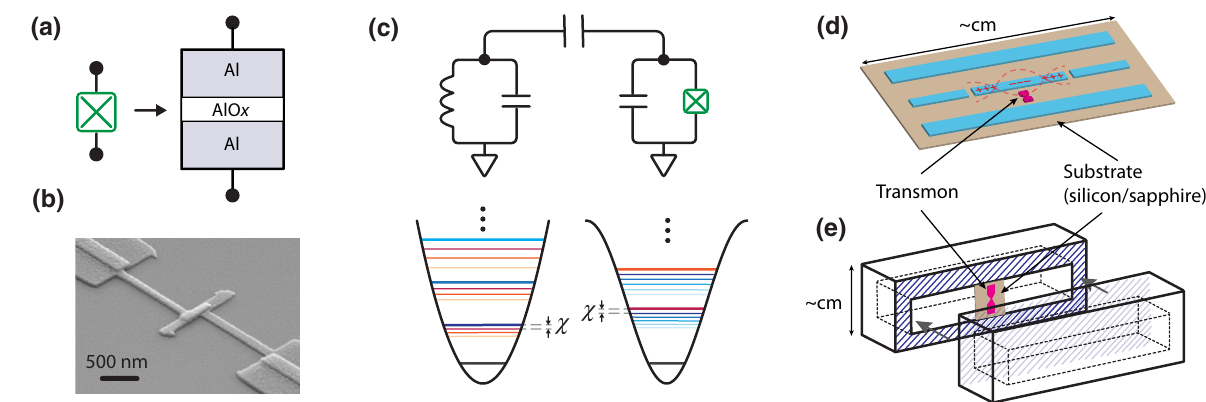
FIG. 3. Dispersive coupling between a transmon and a superconducting resonator. (a) Lumped-element representation of a Josephson junction and a sketch of its structure, which consists of two layers of aluminium (gray) that are separated by an aluminium oxide tunnel barrier (white). (b) A SEM image of a bridge-free junction. Image credit: Kyle Serniak (Yale University). (c) Lumped- element representation of a LC circuit capacitively coupled to a single-junction transmon and the associated the potential of each mode and the dressing of the energy levels due to the dispersive interaction. (d),(e) Two examples of physical realizations of a transmon device dispersively coupled to a superconducting cavity in either the planar (d) or 3D configuration (e). provides the drive and measurement tones to the